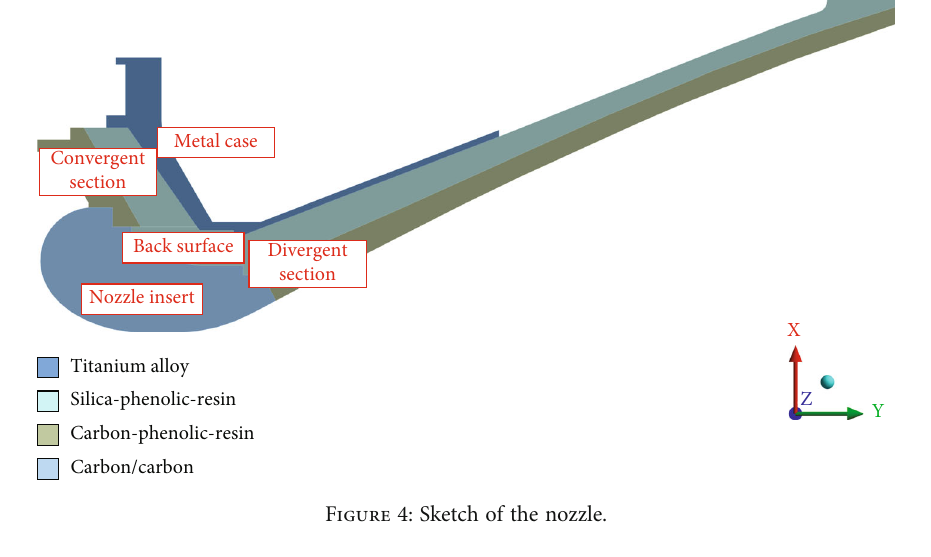
Figure 4: Sketch of the nozzle.